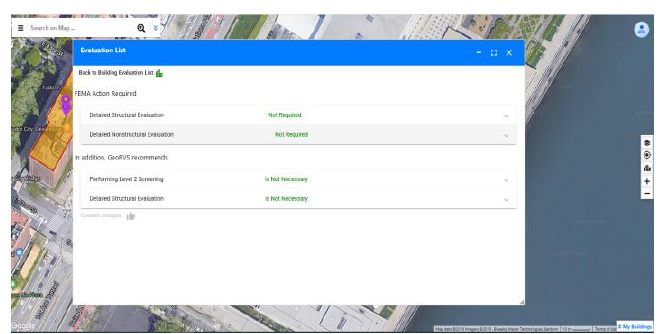
Figure 2. Recommendation for building using GeoRVS for